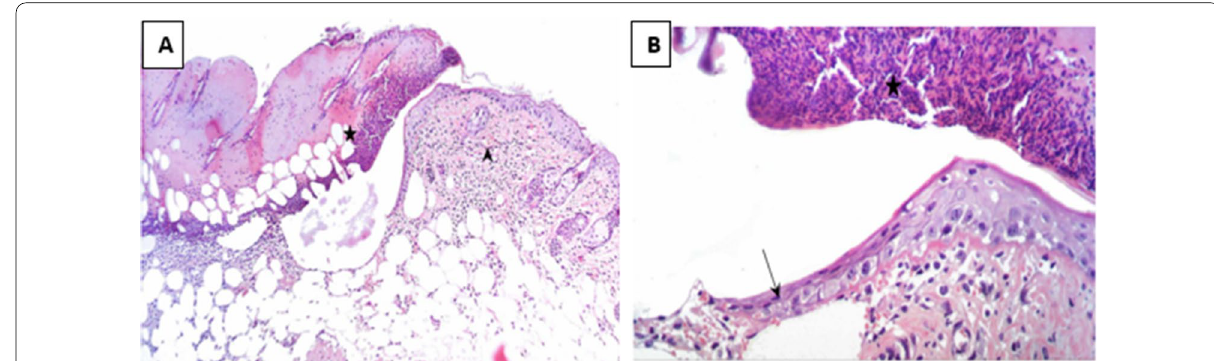
Fig. 3 A Histopathology of skin from Group B (control: burned, uninfected): wound gap filled with necrotic tissue debris (star), sever inflammatory cells infiltration in dermis with scattered congested blood capillaries (arrow head). B Higher magnification from ( A ) showing wound epithelium edge (arrow) covered by necrotic tissue (star) and underlying damaged dermal layer (H&E 400X)